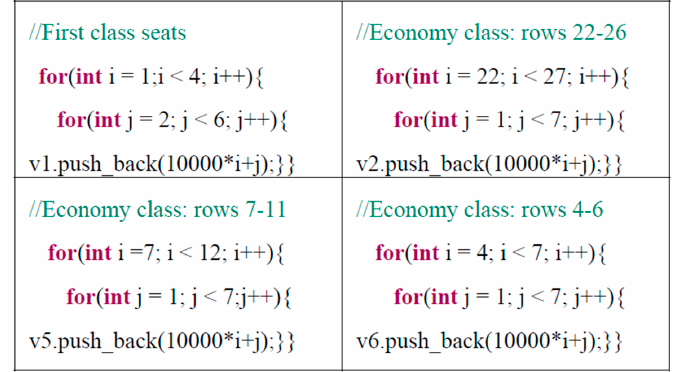
Figure 8. Back-to-Front seat number generation for sample zones: 1, 2, 3 and 6.